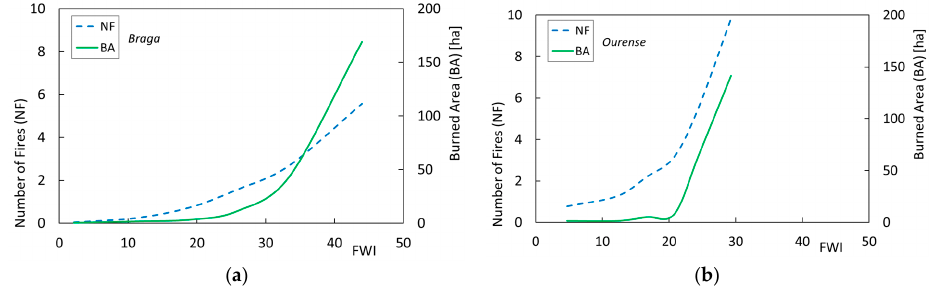
( a ) ( b ) Figure A3. Average number of daily fires (NF) and burned area (BA) as a function of FWI for: ( a ) the Portuguese District of Vila Real and ( b ) the Spanish Province of Ourense.